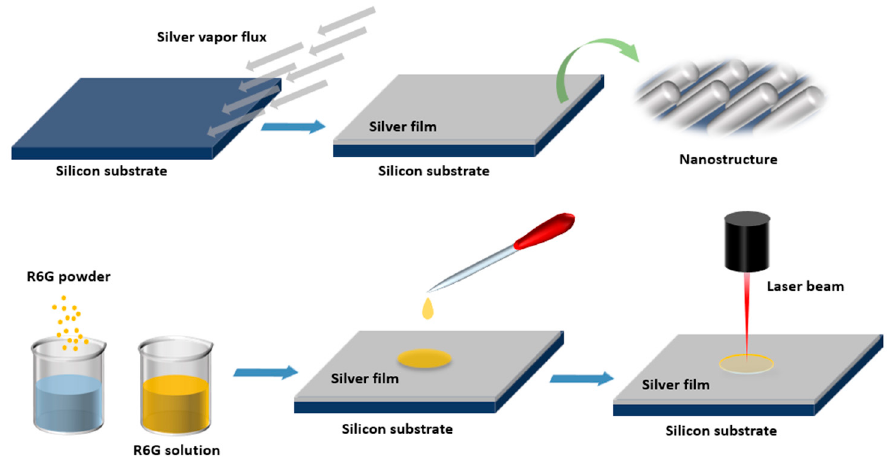
Figure 4. Schematic of fabrication and test process.